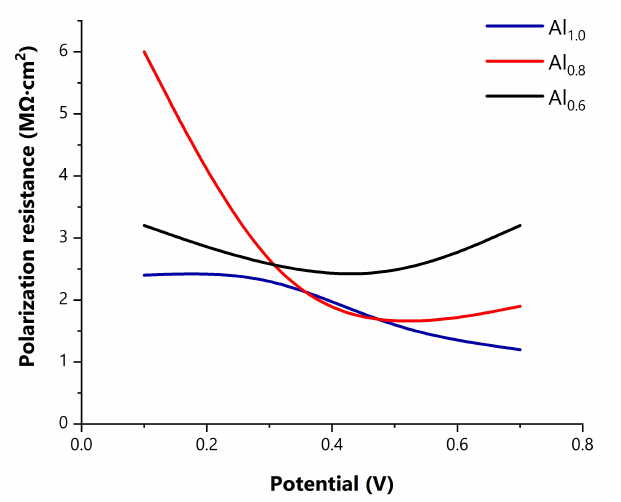
Figure 9. Comparison of polarization resistance of HEA Al x CoCrFeNi with different EIS potentials. Based on